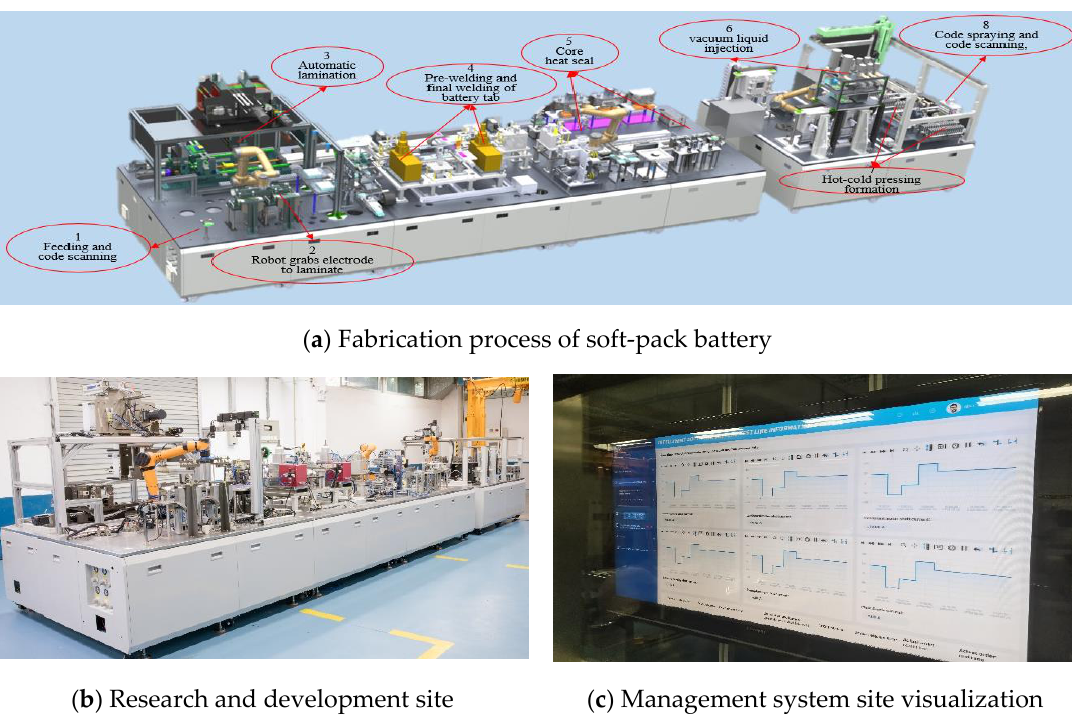
Figure 13. Schematic diagram of production process and site of soft-pack battery.